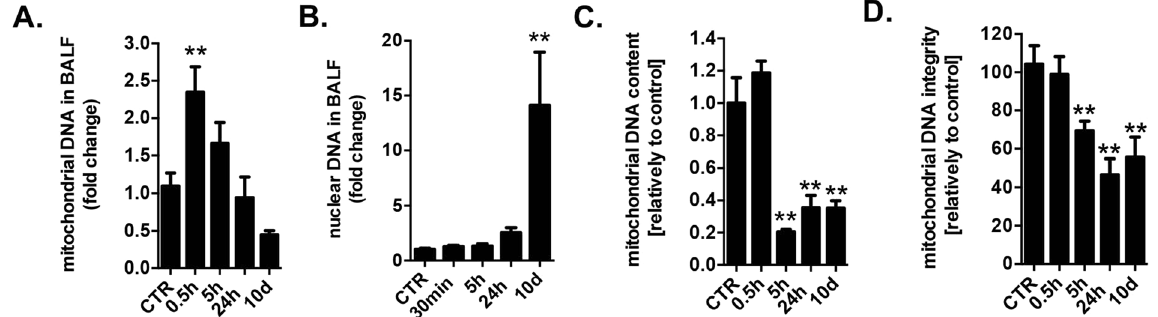
Figure 1. Mitochondrial DNA is released into the bronchoalveolar lavage fluid as an early event in a murine model of cigarette smoke induced lung injury. Early presence of mtDNA ( A ) but not of nuclear DNA ( B ) in BALF of mice exposed to cigarette smoke induced lung injury. MtDNA content is depleted ( C ) and mtDNA integrity is impaired ( D ) in the lung tissue of smoke injured mice. 6–8 animals were used for each experimental end-point. Data represent average ± SEM. ** p < 0.01 vs .